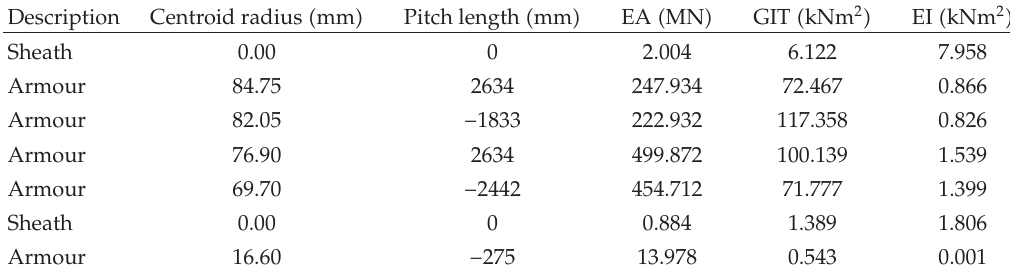
Table 4: Umbilical 1